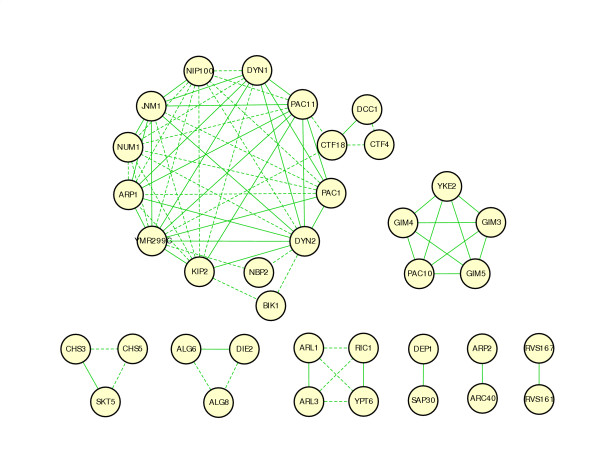
GIMF Type 2 network. This network is created by applying Rule 2 to all the edges in the GIMF Type 1 network. See text for details. The solid edges are inherited from the Type 1 network while the dashed edges are added by applying Rule 2.